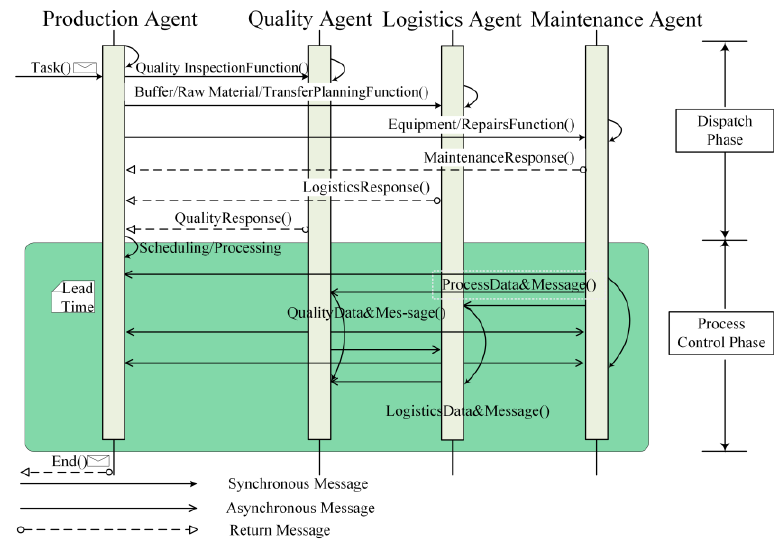
Figure 8. Cooperation protocol of the collaborative and deliberate agent (CDAs).